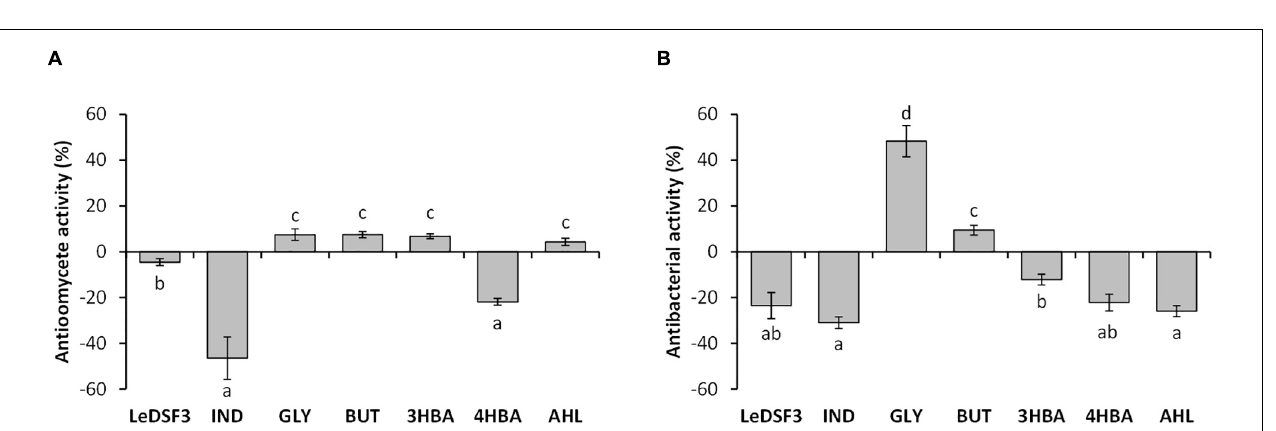
FIGURE 1 | Effect of diffusible communication signals on the inhibitory activity of Lysobacer capsici AZ78 against (A) Pythium ultimum and (B) Rhodococcus fascians . Antioomycete and antibacterial activities are expressed as the mean value and standard error variation (percentage) of the reduction of the mycelium growth area of P. ultimum and R. fascians compared with the control ( L. capsici AZ78 in not supplemented media), respectively. LeDSF3, 13-methyltetradecanoic acid 50 µ M; IND, indole 500 µ M; GLY, glyoxylic acid 0.01 µ M; BUT, 2,3-butanedione 0.01 µ M; 3HBA, 3-hydroxybenzoic acid 30 µ M; 4HBA, 4-hydroxybenzoic acid